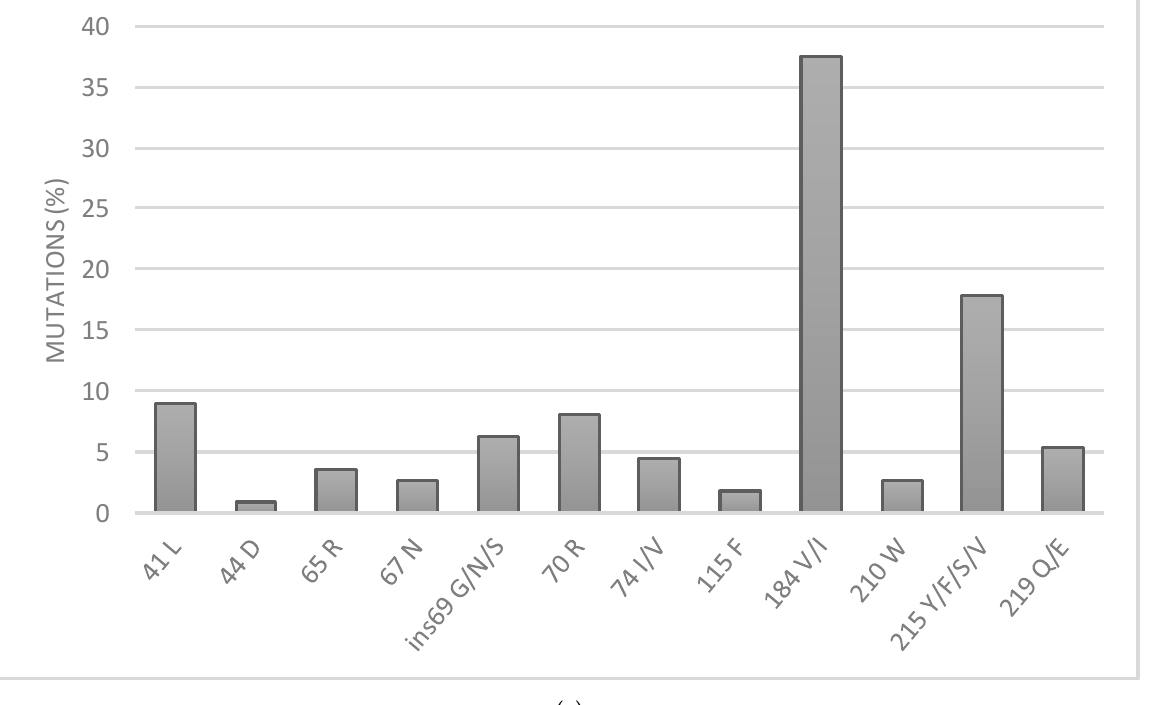
( b ) Figure 3. Observed frequency of mutations conferring resistance to ( a ) nucleoside reverse transcriptase inhibitors (NRTIs) and ( b ) non-nucleotide reverse transcriptase inhibitors (NNRTIs).